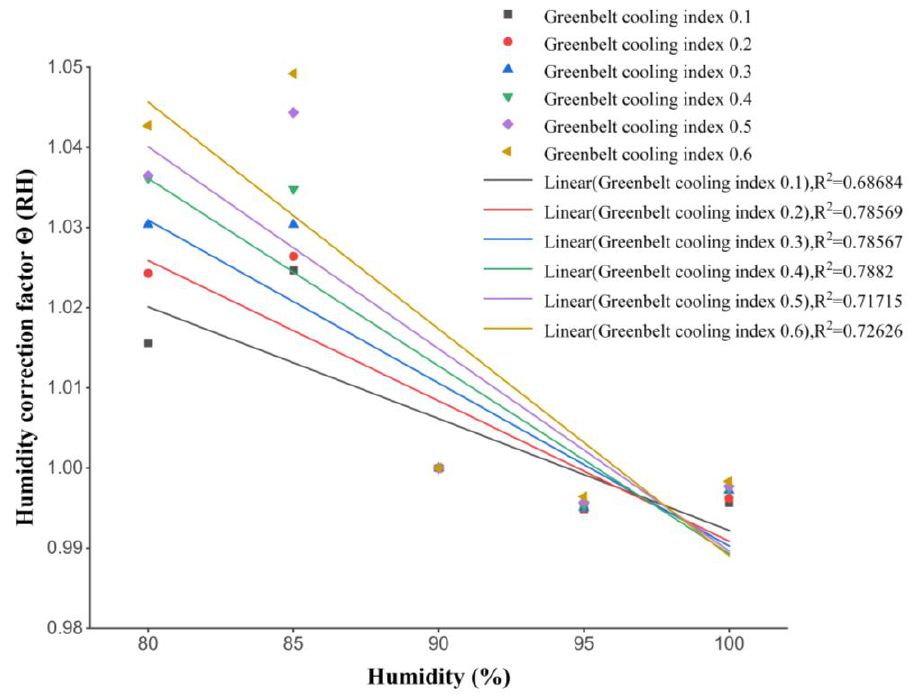
Figure 10. Influence of humidity on cooling effects of green space.